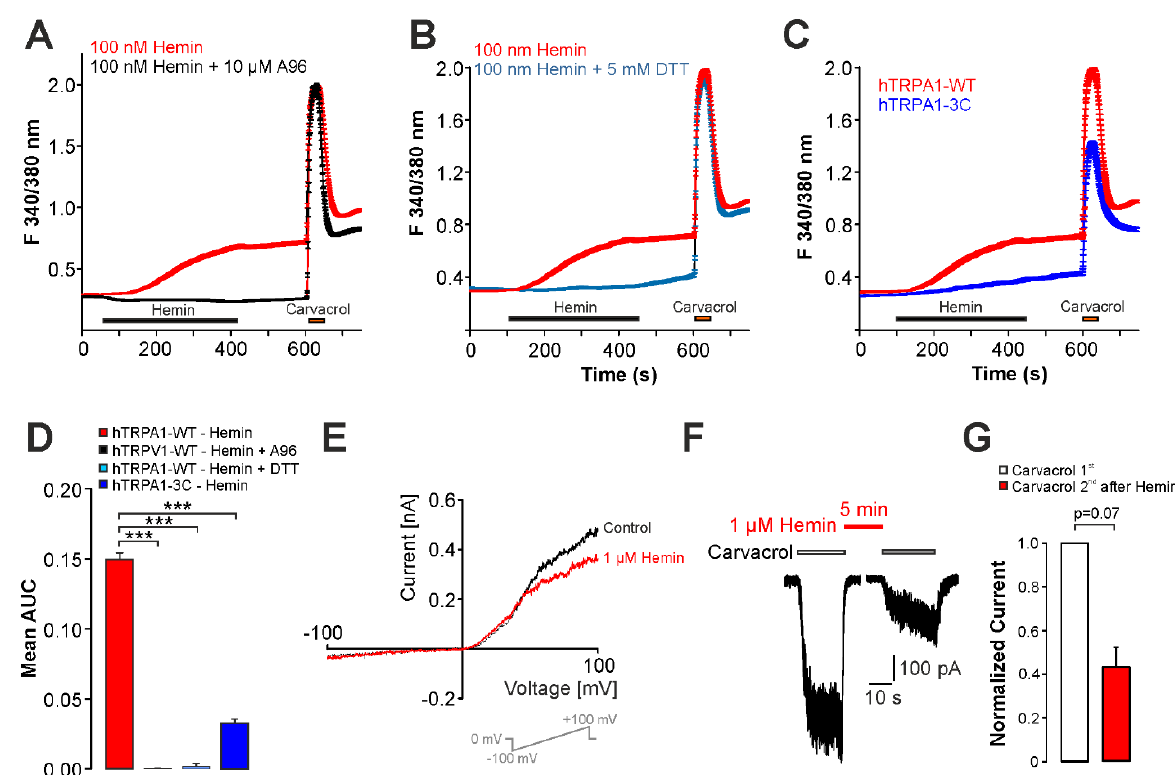
Figure 7. Hemin activates hTRPA1 expressed in HEK293t cells. ( A ) Hemin-induced (100 nM) calcium responses in hTRPA1-expressing cells with or without application of the TRPA1-inhibitor A967079 (10 µM). Hemin was applied for 300 s followed by washout and the TRPA1-agonist carvacrol (200 µM). ( B ) Mean calcium responses in hTRPA1-expressing cells treated with 100 nM hemin or hemin together with 5 mM DTT. ( C ) Mean calcium responses in cells expressing hTRPA1-WT or hTRPA1-3C treated with 100 nM hemin for 300 s. ( D ) Mean area under the curve (AUC) for the hemin-induced increase in fluorescence ratio for experiments described under ( A – C ). ANOVA F(3, 2583)=156.07, p < 0.001. ( E ) Representative whole-cell patch clamp recording on a HEK293t cell expressing hTRPA1. Membrane currents were evoked by a 500 ms long voltage-ramp from − 100 to +100 mV. Note that hemin reduces the membrane current. ( F ) Whole-cell patch clamp recordings on hTRPA1-expressing cells challenged with two consecutive applications of carvacrol with 1 µM hemin applied for 5 min between both applications. ( G ) Mean normalized peak amplitudes of inward currents evoked by carvacrol ( F ). Current amplitudes were normalized to the amplitude of the first current. Cells were held at − 60 mV in all patch clamp experiments. Data are shown as mean ± S.E.M. *** denotes p< 0.001.